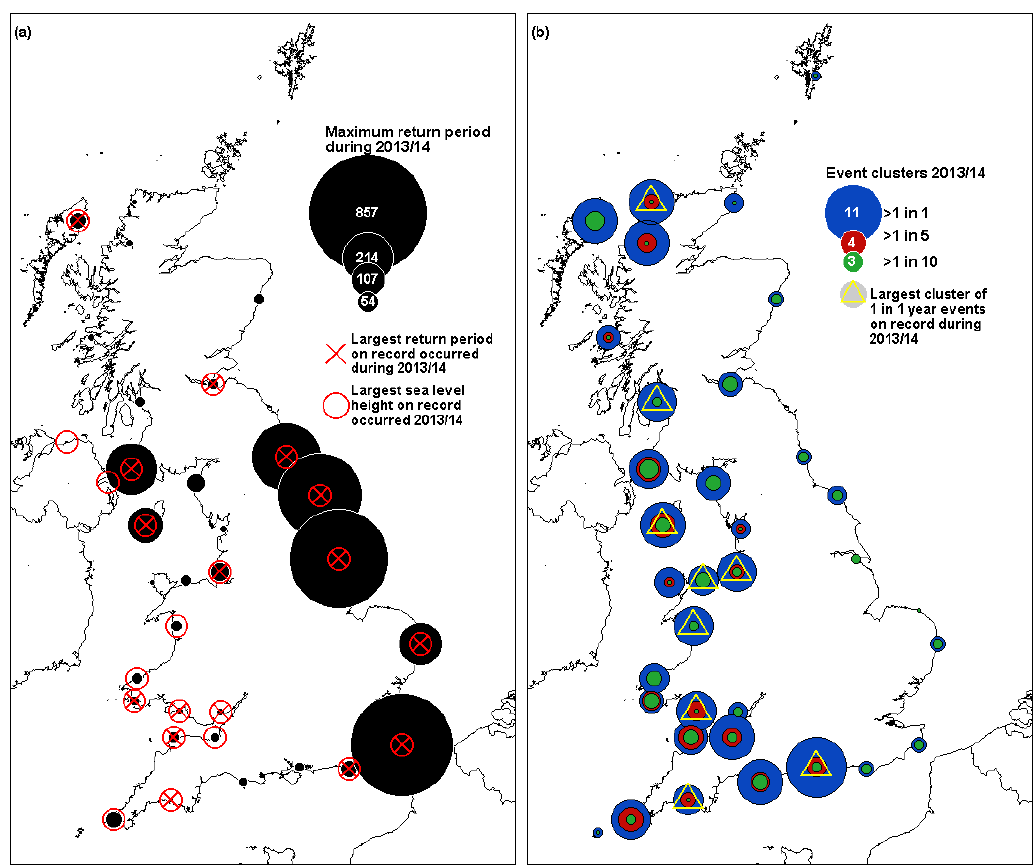
Figure 6. The methods shown for Newlyn are extended to the UK’s Class A tide gauge sites (for which both return periods and 2013/2014 sea level time series are available); (a) the largest return periods during the July–July 2013/2014 year (note that the return period data set does not cover Bangor, Portrush and Jersey); (b) clustering of events above the 1 in 1-year return period threshold. For reference to the locations and data spans at each location, see Fig. 1b.